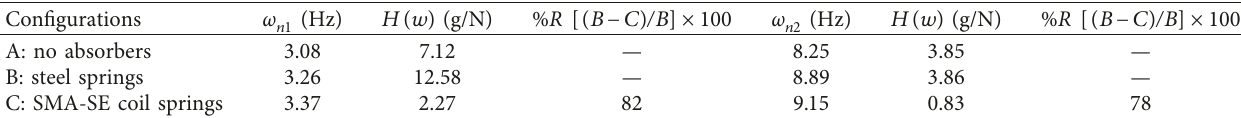
Figure 14: Experimental FRF of the system for the configurations adopted in this study. Table 5: Natural frequencies and percentage reduction of amplitudes in free vibration tests.